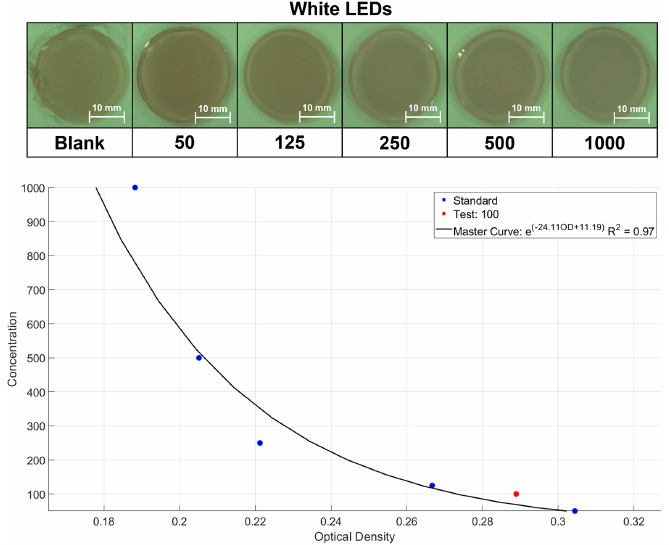
Figure 6. Correlations of HSA concentration and optical density in the range from 0 to 1000 mg/L under white LEDs. The black line represents the established master curve, R 2 = 0.97; the red dot represents the validated sample. TC426 = 10 μ M.